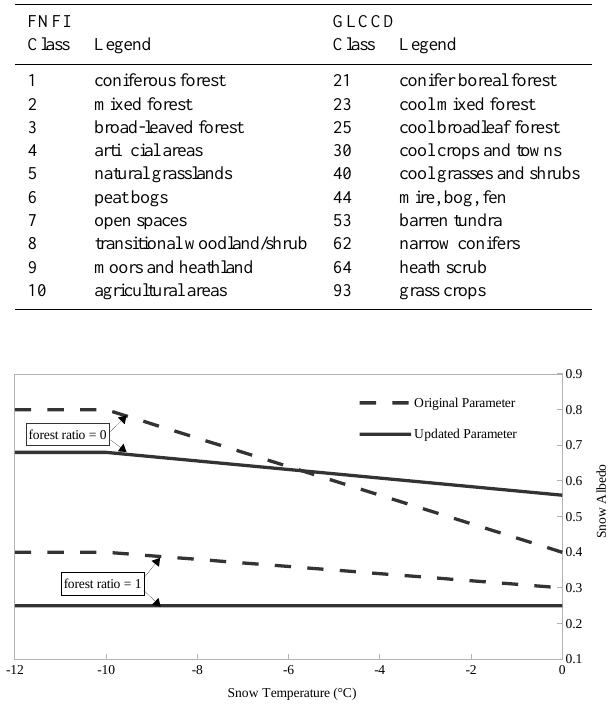
Table B1. Translations between the 10 land cover classes in FNFI maps and the GLCCD land cover classes.